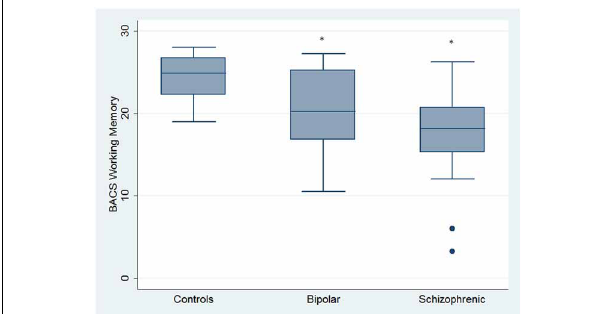
FIGURE 2 | Differences between groups in neuropsychological tasks: BACS working memory. • Outliers. ∗ Significantly different from HC ( p < 0 . 05).